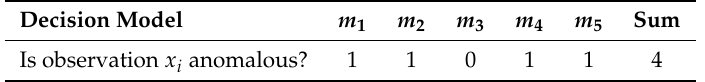
Table 1. Prediction results for a set of decision models on a testing observation x i